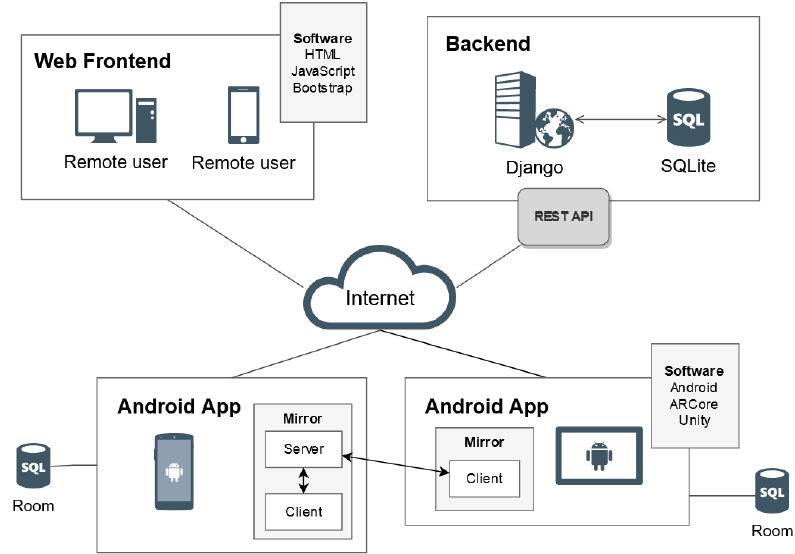
Figure 2. Implemented communications